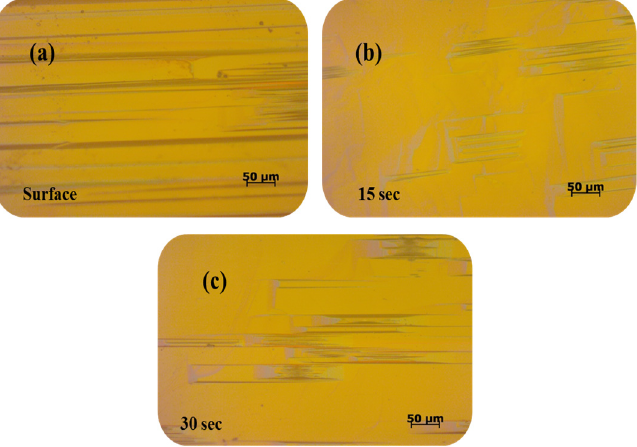
Figure 12. ( a ) MMPI crystal surface, ( b , c ) Etched for 15 s and 30 s.